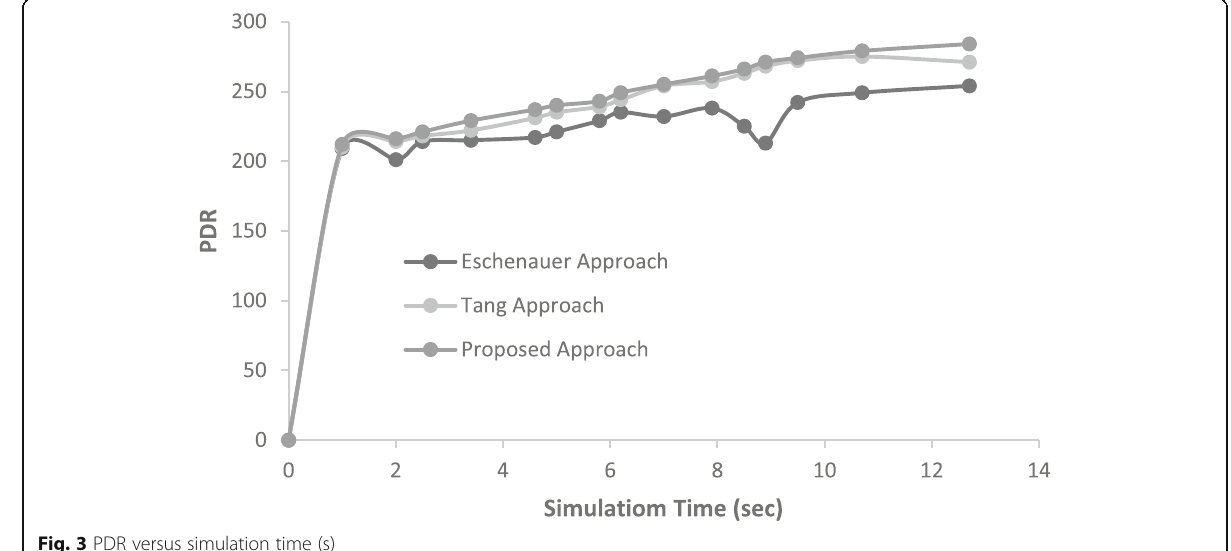
Fig. 3 PDR versus simulation time